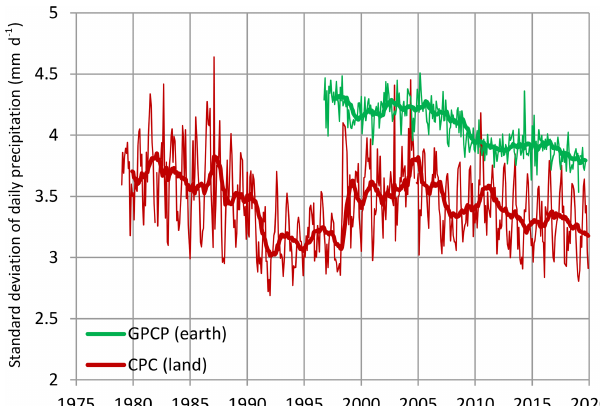
Figure B3. Variation of the standard deviation of daily precipitation in each month, areally averaged. Thin and thick lines of the same colour represent monthly values and running annual averages (right aligned), respectively. Sources of the data are indicated in the legend and detailed in Table